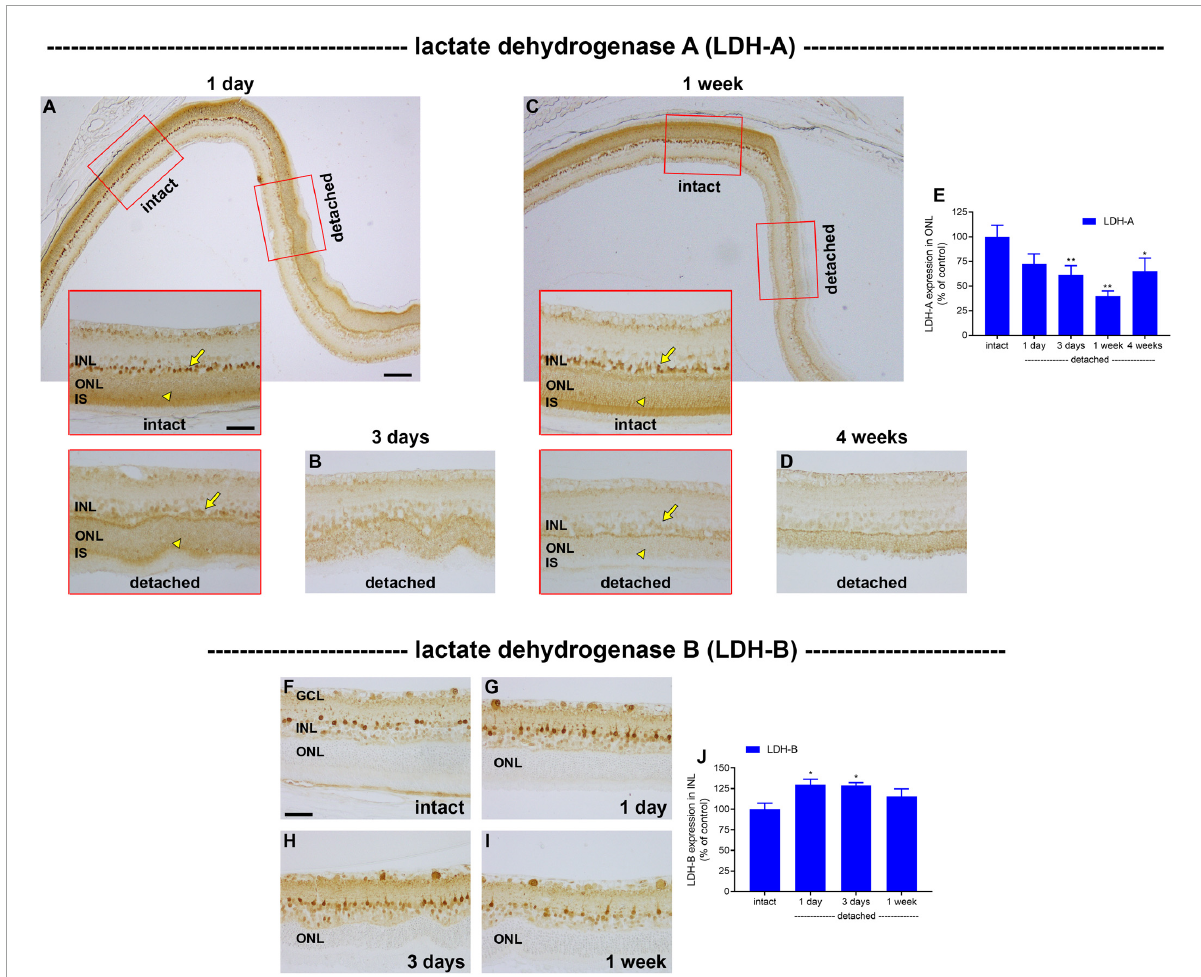
FIGURE6 Effect of retinal detachment on expression of lactate dehydrogenase (LDH)-A and -B subunits, as evaluated by immunohistochemistry. (A–D) Representative images of LDH-A immunolabelling in intact retina, and at 1 day, 3 days, 1 week, and 4 weeks after detachment. Arrows highlight bipolar cells; arrowheads demarcate photoreceptor cell bodies. (E) Quantification of LDH-A immunoreactivity within the outer nuclear layer (ONL) at 1 day, 3 days, 1 week, and 4 weeks after retinal detachment. Values, shown as % of the intact group, represent mean ± SEM. * P < 0.05, ** P < 0.01 by one-way ANOVA followed by post-hoc Dunnett’s multiple comparisons test (intact vs. detached). Scale bars: (A) (insets), (B,C) (insets), (D) = 60 µ m; (A,C) (overview) = 150 µ m. (F–I) Representative images of LDH-B immunolabelling in intact retina, and at 1 day, 3 days, and 1 week after detachment. Scale bar: 60 µ m. (J) Quantification of LDH-B immunoreactivity within the inner nuclear layer (INL) at 1 day, 3 days, 1 week, and 4 weeks after retinal detachment. Values, shown as % of the intact group, represent mean ± SEM. * P < 0.05 by one-way ANOVA followed by post-hoc Dunnett’s multiple comparisons test (intact vs.